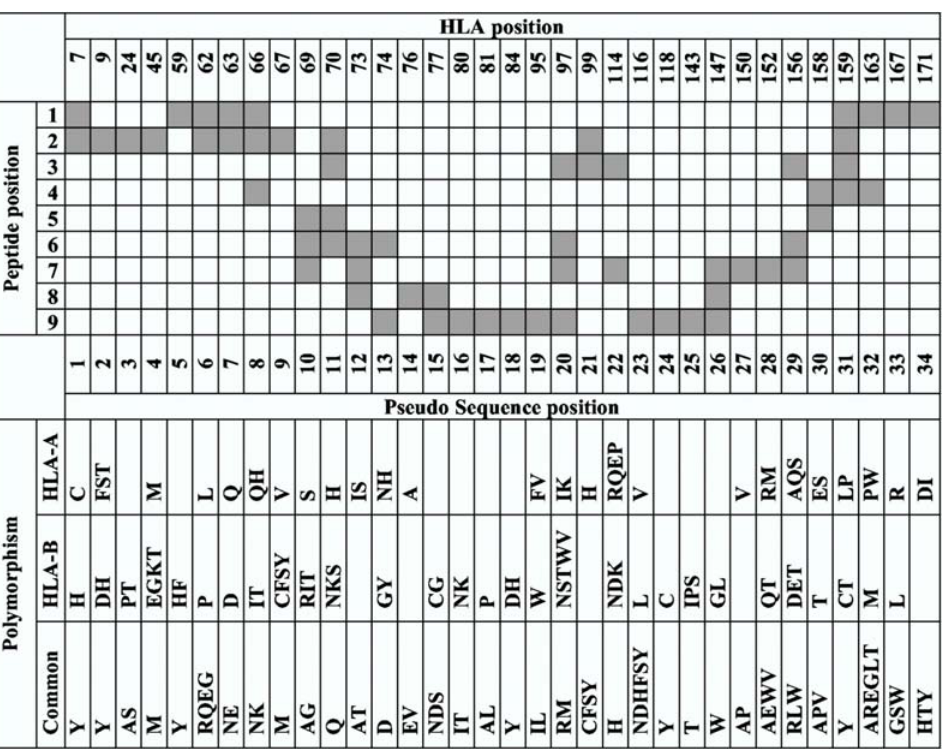
Figure 4. Definition of the HLA pseudo sequence. The upper part of the figure shows the residues of the HLA sequence estimated to be in contact with the peptide in the binding cleft. The columns give the HLA residue numbering according the IMGT nomenclature. The rows demonstrate the interactions with the nine peptides positions. Squares in grey outline the peptide positions estimated to have contact the corresponding HLA residue. The lower part of the figure shows the amino acid polymorphism at each position in the pseudo sequence, both those that are common for HLA-A and –B, and those that are unique for the HLA-A and HLA-B loci, respectively (as of February 2007).